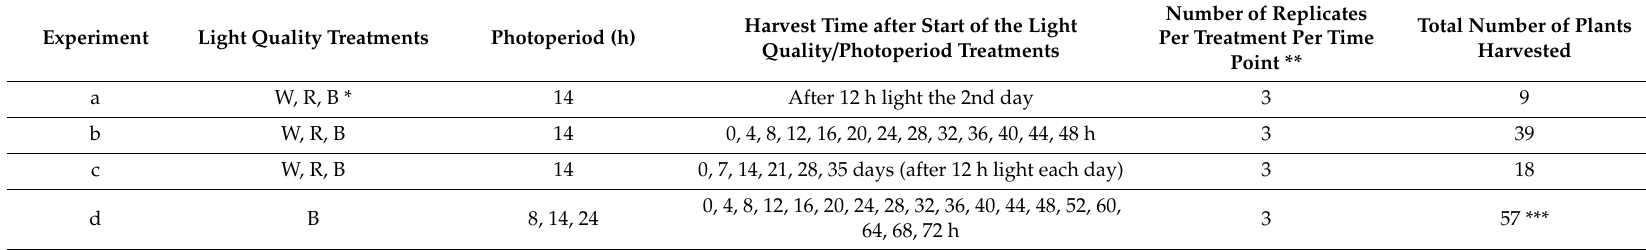
Table 1. Overview of the experiments for studies of ELF4-1 and EL4-2 transcript levels in